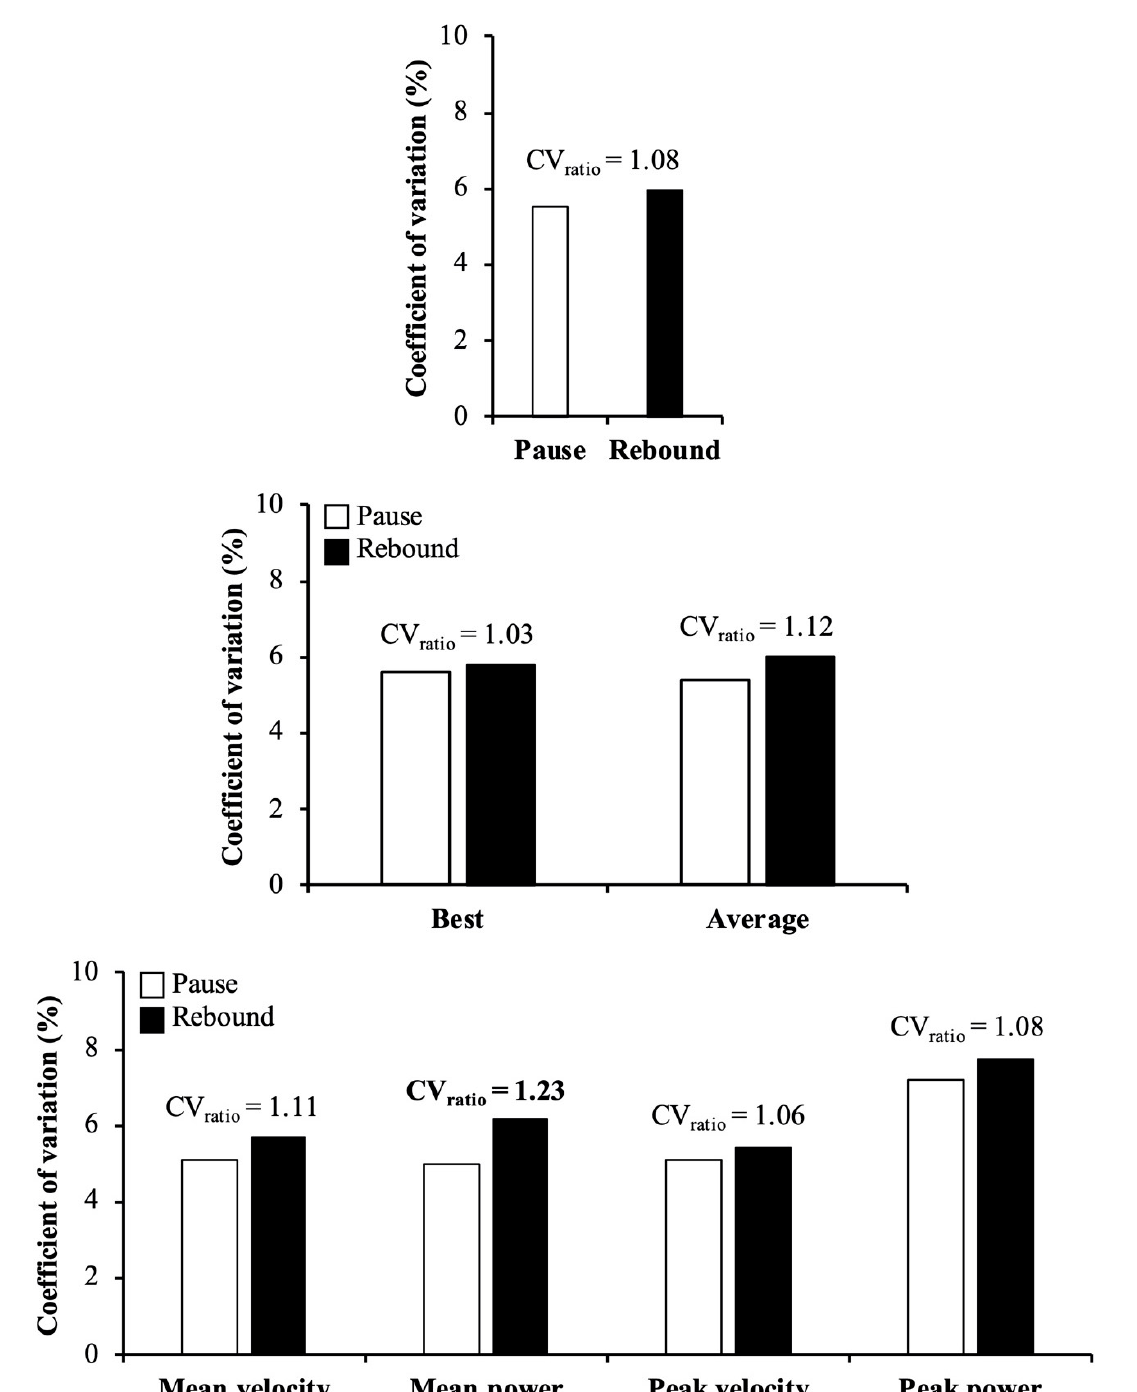
Figure 3. Reliability comparisons between best (white bars) and average (black bars) scores reported during the back-squat exercise. Bars represent the median coefficient of variation value obtained combining the 2 exercise techniques and 4 variables (upper panel), the 4 variables separately for each exercise technique (middle panel), and the 2 exercise techniques separately for each variable (lower panel). Numbers depict the ratio between 2 coefficients of variation (CV ratio = higher/lower value), while meaningful differences in reliability are indicated in bold (CV ratio > 1.15).